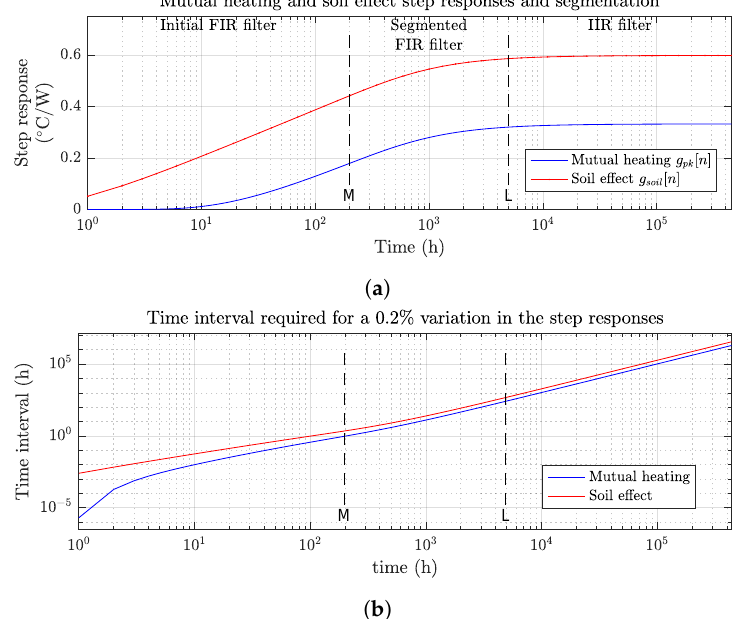
Figure 6. Mutual and soil thermal step responses: ( a ) partitioning of the mutual and soil step responses into separate segments; and ( b ) time interval required for the step response to increase by